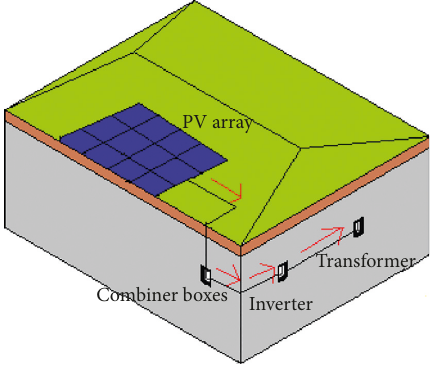
Figure 1: Photovoltaic building